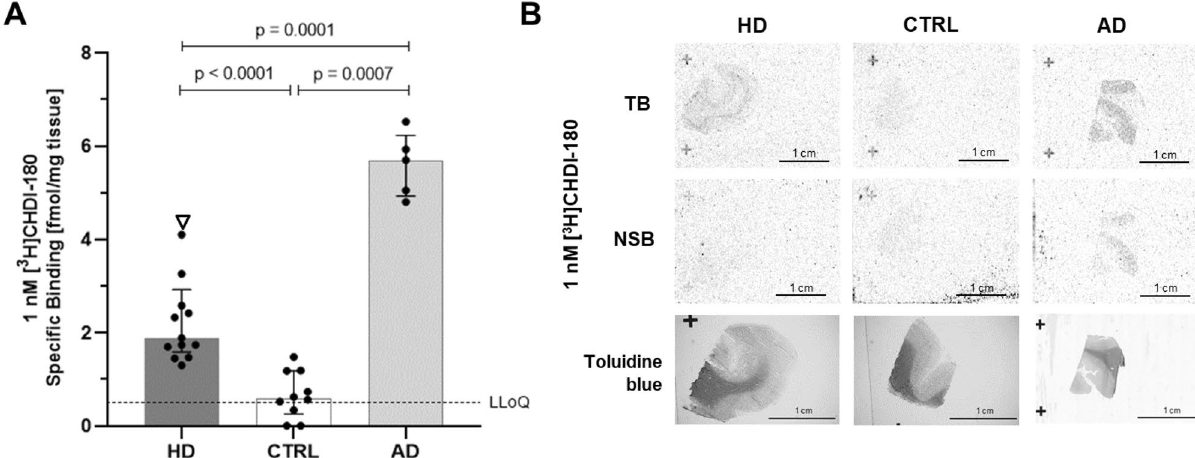
Figure 6. ARG studies investigating CHDI-180 ligand binding to human HD, AD and CTRL brain sections. ( A ) Specific binding in gray matter of [ 3 H]CHDI-180 to human brain sections (frontal cortices) in in situ ARG. Black circles indicate binding to individual adult HD brains, the white triangle depicts binding to one juvenile HD case. Data shown as median ± interquartile range. Statistical analysis by Mann–Whitney test, two-tailed, 95% confidence level. LLoQ: lower limit of quantification ( B ) Representative images of [ 3 H]CHDI-180 total binding (TB) and non-specific binding (NSB) in human HD, AD and CTRL brain sections. Toluidine blue staining was used to discriminate white matter (dark gray) and gray matter (light gray) in the same section used for